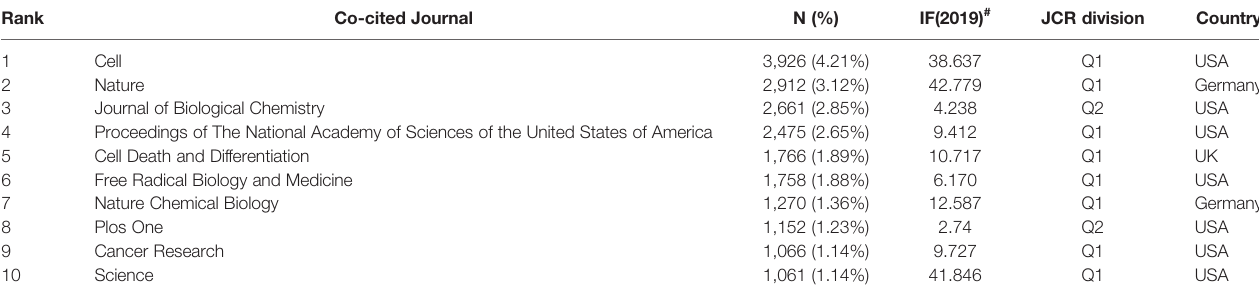
TABLE 2 | The top 10 co-cited journals of ferroptosis research.